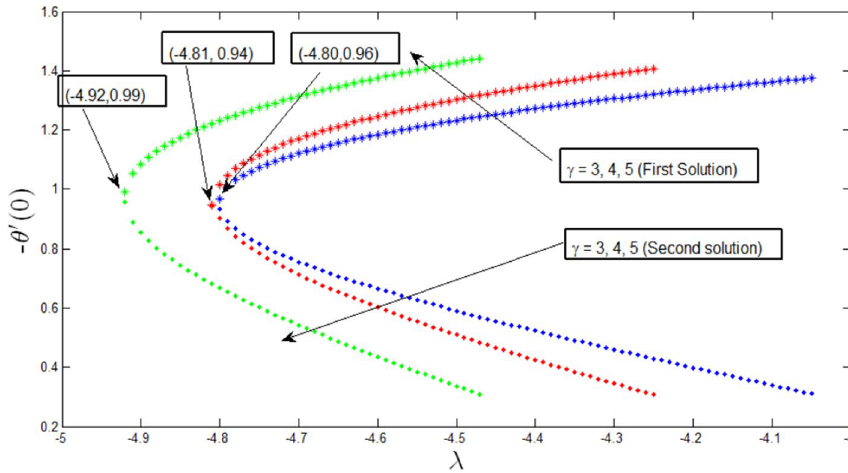
Figure 6. Variation of Nusselt number with (cid:31) for various γ when Lb = 1, Le = 1, Pb = 1, Nr = 0.5, Rb = 0.6, A = 0.2.